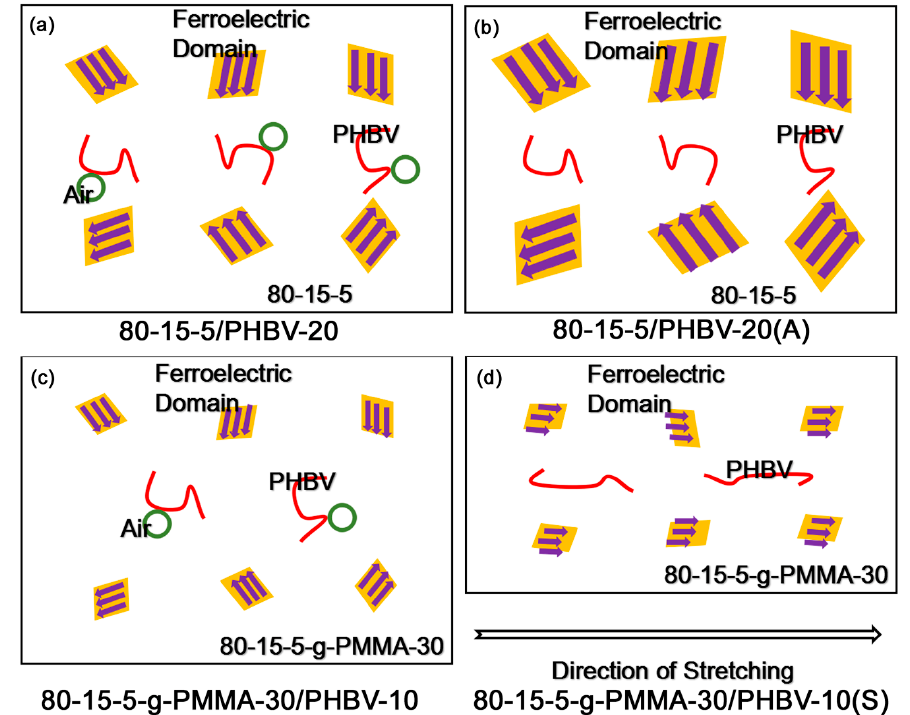
Figure 8. Schematic diagrams of ( a ) 80-15-5/PHBV-20 sample with randomly oriented middle ferroelectric domains and with interface air defects; ( b ) annealed 80-15-5/PHBV-20 sample with randomly oriented large ferroelectric domains and with high interface adhesion; ( c ) 80-15-5-g-PMMA-30/PHBV-10 sample with randomly oriented small ferroelectric domains and with air defects; and ( d ) stretched 80-15-5-g-PMMA-30/PHBV-10 sample with regularly oriented small ferroelectric domains and PHBV as well as with high interface adhesion.